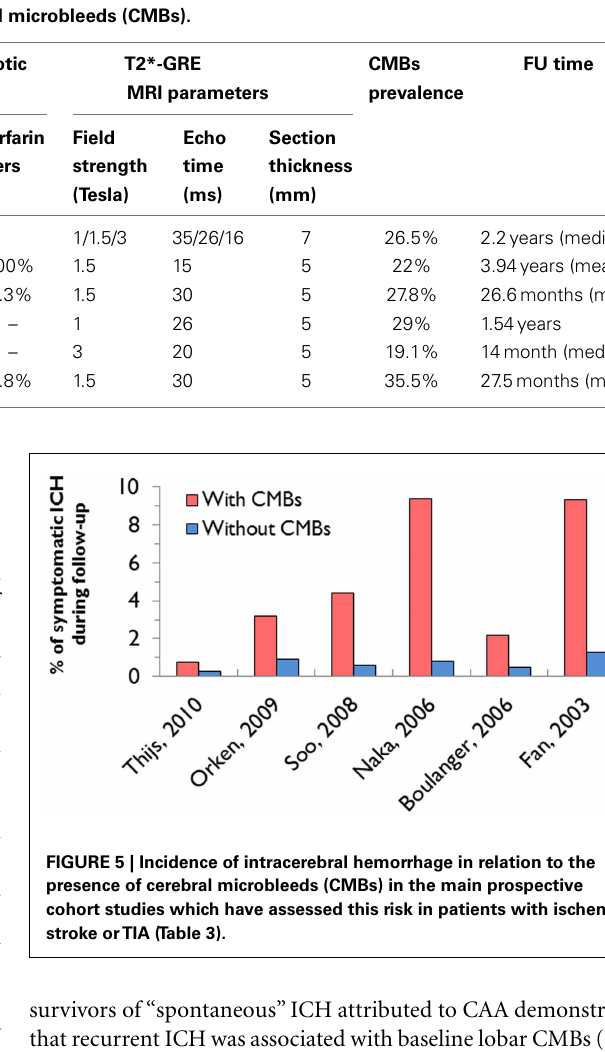
survivors of “spontaneous” ICH attributed to CAA demonstrated that recurrent ICH was associated with baseline lobar CMBs (haz- ard ratio: 2.93 for 2–4 CMBs and 4.12 for > 5 CMBs; Biffi et al.,